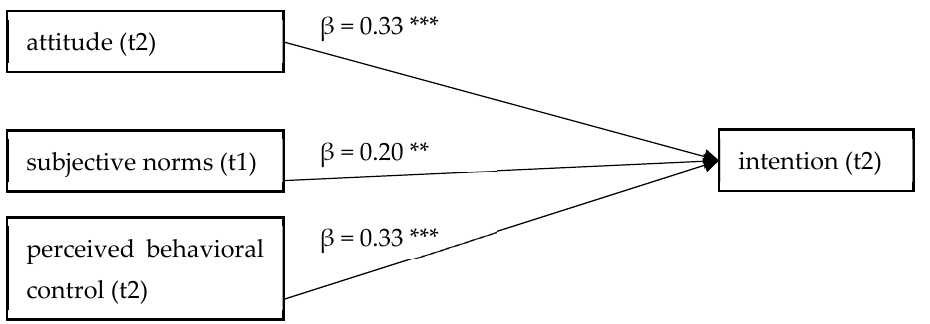
Figure 1. Results of a regression analysis on the interrelations of TPB-constructs with intention (t2) as the criterion; *** p < 0.001, ** p < 0.01.